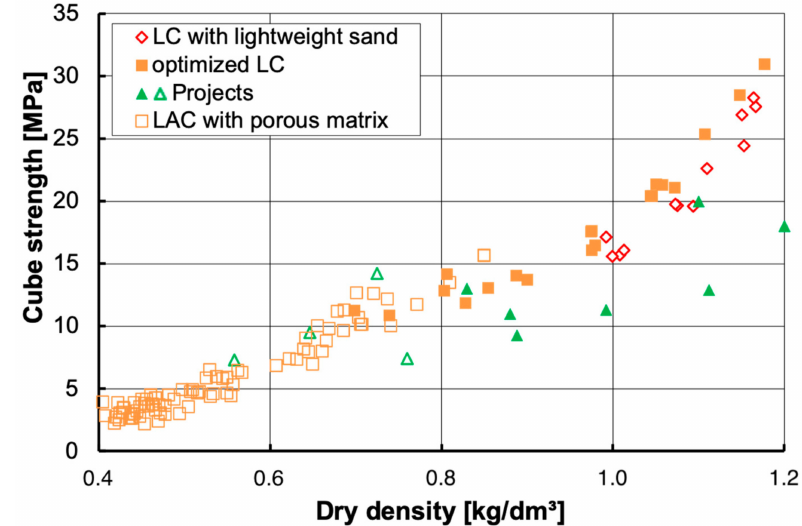
Figure 10. Correlation between 28-day cube strength and dry density for lightweight concretes (LC) with lightweight sand [143], lightweight aggregate concrete (LAC) with porous matrix di ff erent compositions [43], data for two ILC projects [18,48] and most recent LAC-based ILC projects